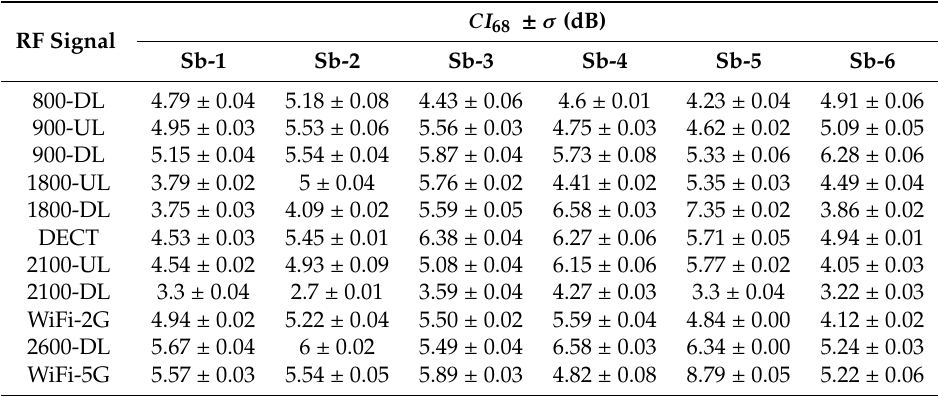
Table 5. 68% confidence interval of the on-body antenna aperture for different subjects wearing the BWDM (combination of two antennas per frequency band).